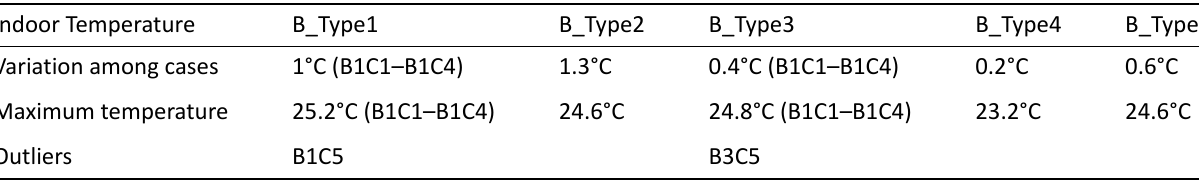
Table 2. Patterns of indoor temperatures per building